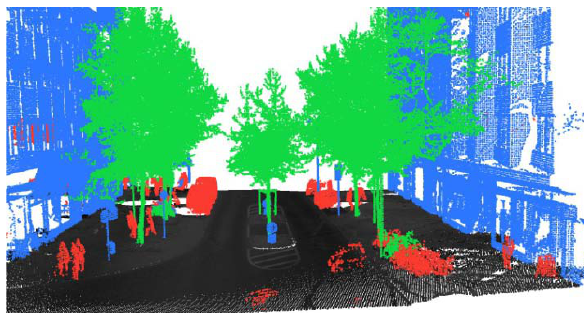
Figure 4: Point cloud with classified trees in green, detected dynamic objects in red and static objects in blue. The ground is colored by the point intensity values.